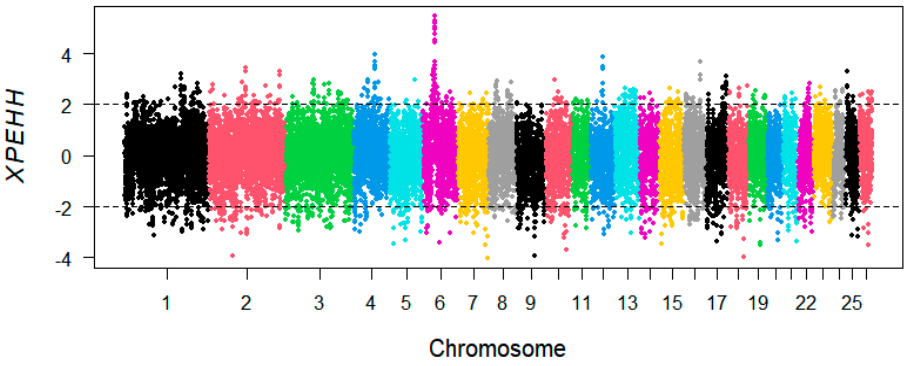
Figure 3. Analysis of selection signal distribution on sheep autosomes. Chromosomes 1 to 26 are shown in different colors; the horizontal dotted black line indicates the genome-wide significance level.